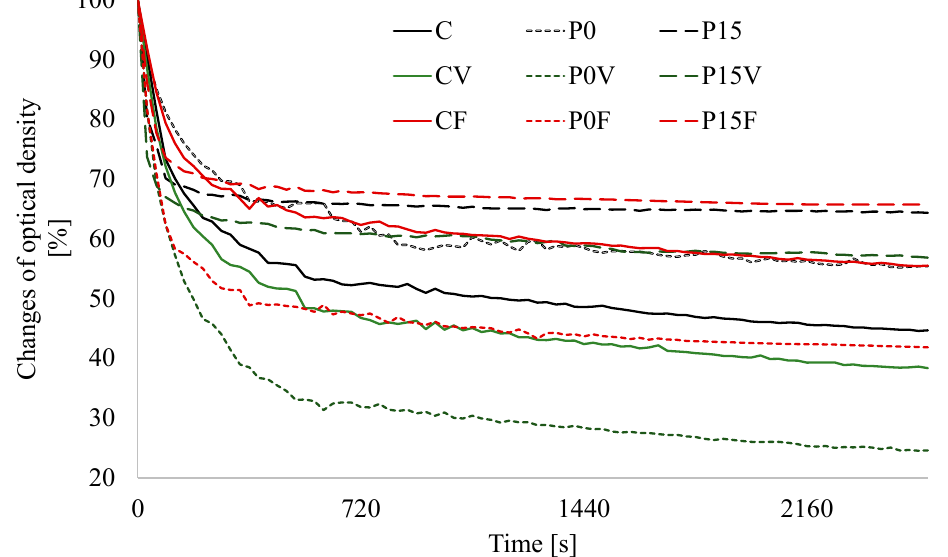
Figure 2. Anticancer properties of the beverages. ( A ) AGS (Human Caucasian gastric adenocarcinoma); ( B ) HT 29 (Human Caucasian colon adenocarcinoma). 1x-D, 3x-D (lyophilized digests applied at concentrations being the equivalents of 0.7% and 2.1% beverage, respectively); 1x-P, 3x-P (potentially bioaccessible phenolics applied at concertation being the equivalents of 0.7% and 2.1% beverage, respectively). C—beverages based on lentil sprouts; P—beverages based on lentil proteins; V—lyophilized parsley and broccoli sprouts; F—lyophilized strawberry and raspberry; 0–15—amounts of flaxseeds gum (%). Means (±SD) followed by different letters are significantly different ( n = 9; p ≤ 0.05).